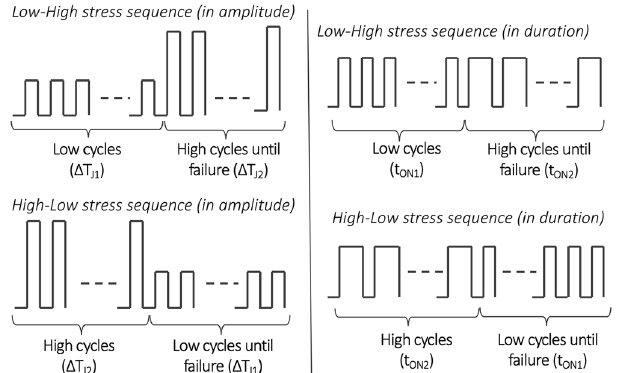
Figure 2. Load sequences in stress amplitude (left) and stress duration (right).